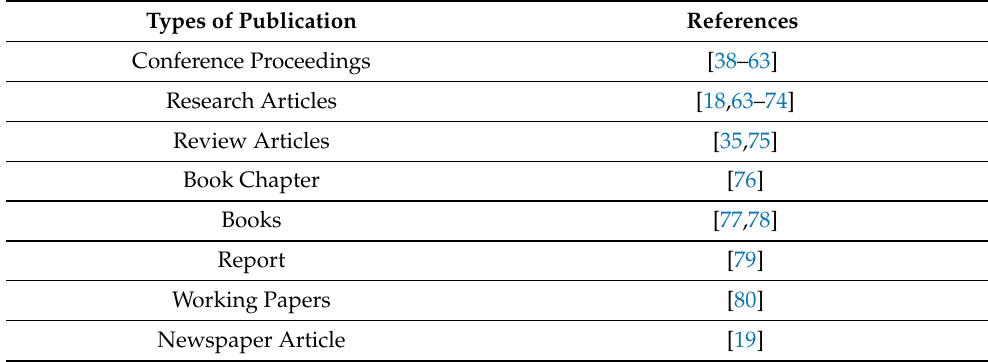
Table 1. Publications and references of various